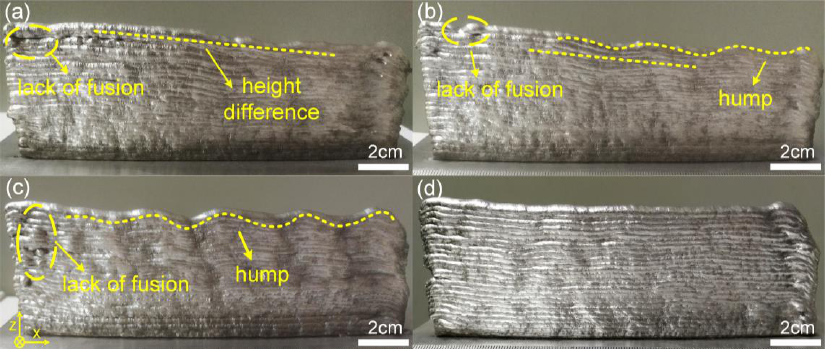
Figure 3. Macroscopic appearance of AZ31 thin-wall components at different oscillation frequencies. ( a ) 0 Hz; ( b )100 Hz; ( c ) 200 Hz; ( d ) 300 Hz.